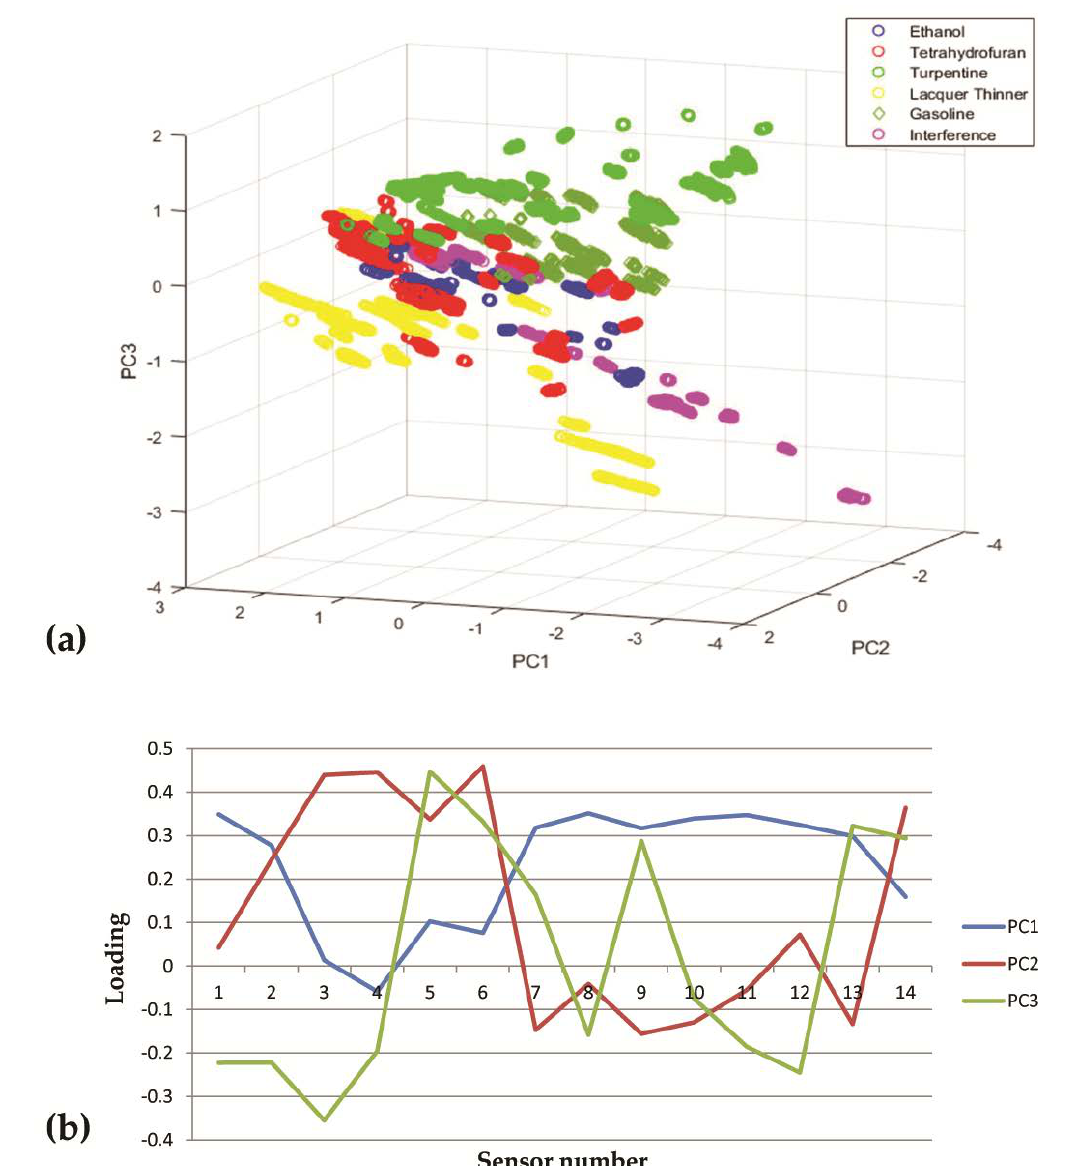
Figure 5. The principal component analysis (PCA). ( a ) Classification results of five flammable liquid samples and three interfering samples, ( b ) loadings of PCA.